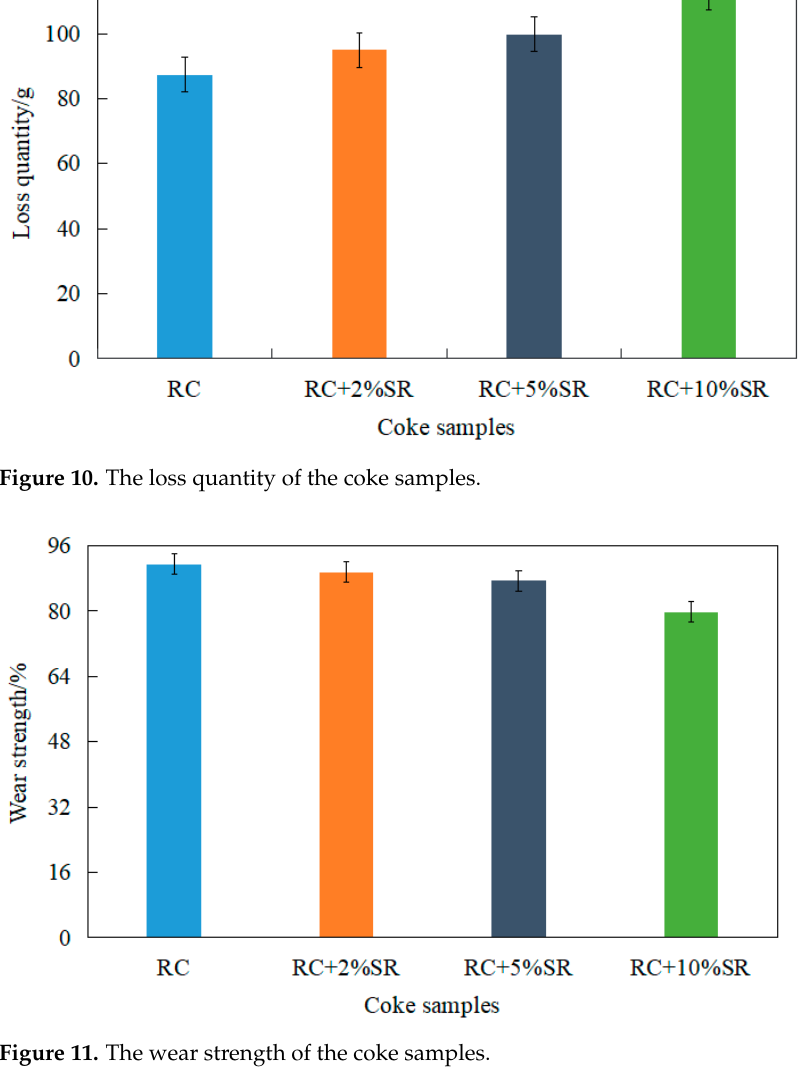
Figure 12. Thermal properties of four kinds of coke at different reaction temperatures.